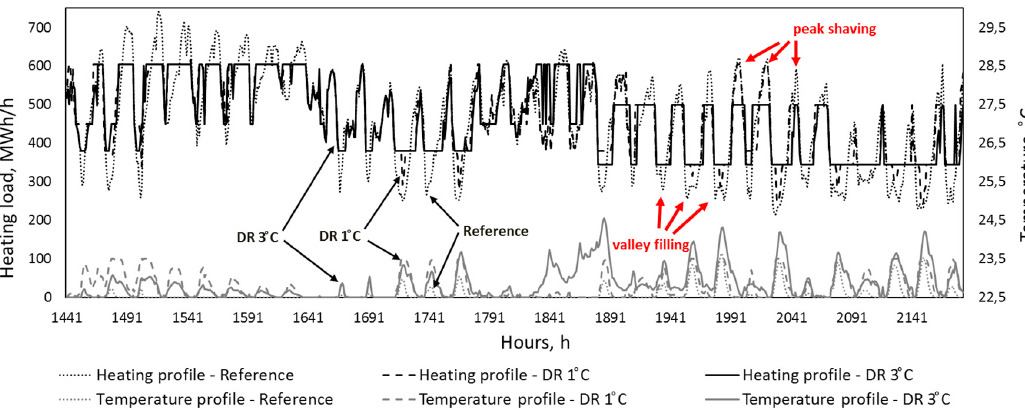
Figure 3. Heating demands of the DH system of the City of Gothenburg and the average indoor air temperatures in the representative multi-family houses that were investigated, as obtained through EBUC modeling for March 2012 in the Reference, DR 1 °C, and DR 3 °C scenarios.